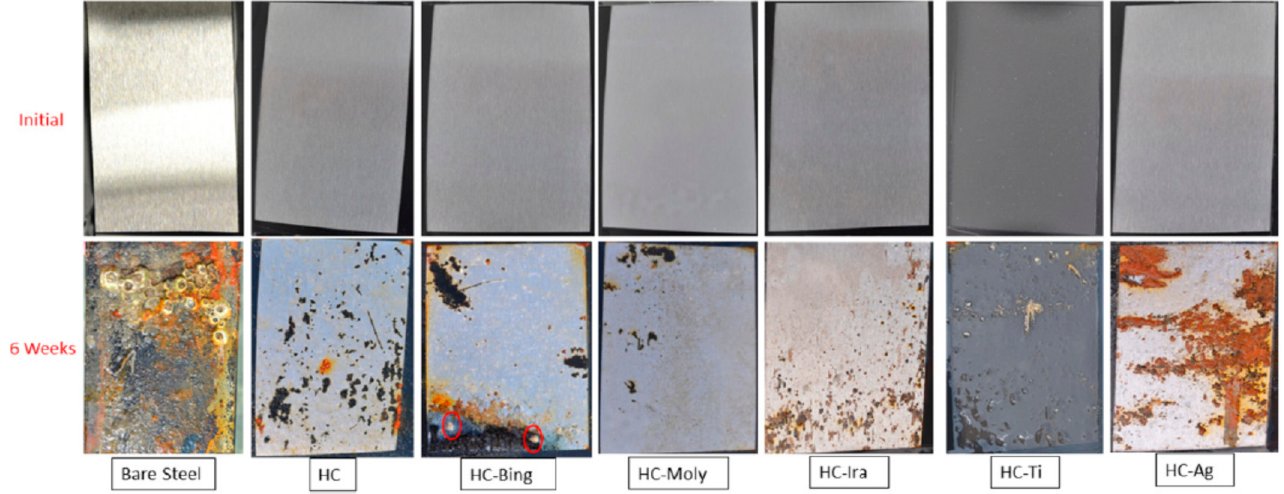
Figure 11. Field trial samples of all coating matrices compared with bare/uncoated steel after 6 weeks of exposure to seawater in the Eastern Province of Saudi Arabia, which has minimal flow and is known for its marine macrofouling activities and high salinity [94].